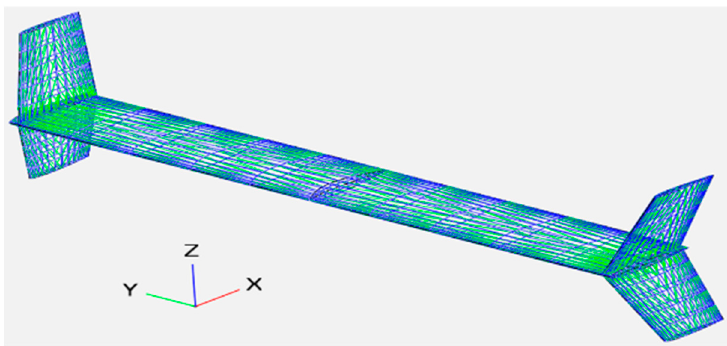
Figure 2. Vahana main wing by using OpenVSP. Appl. Sci. 2020 , 10 , 5112